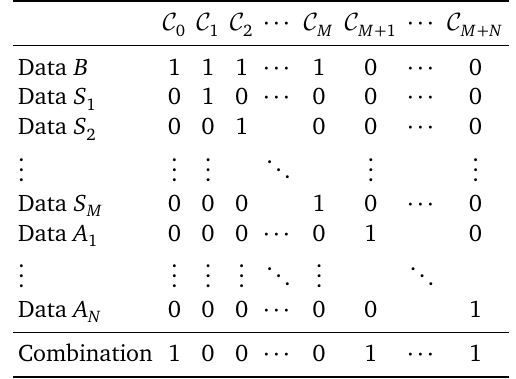
Table 2: Details for the category selection in the general